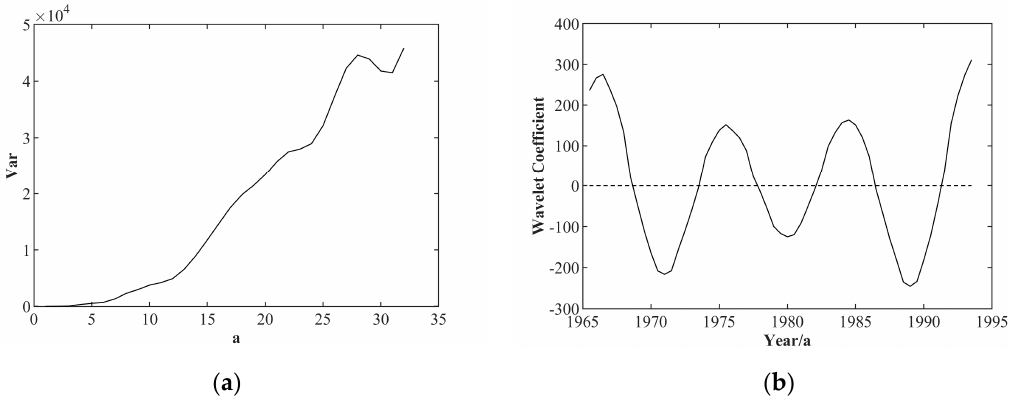
Figure 12. ( a ) The wavelet variance analysis chart; ( b ) the wavelet coe ffi cient chart for the 28a time scale. Figure 12